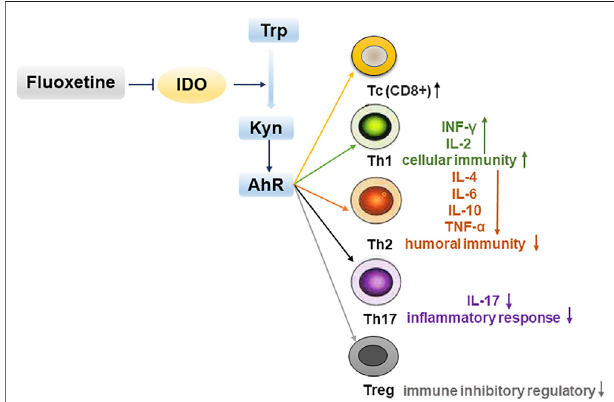
FIGURE 10 | Fluoxetine enhances cellular immunity via down-regulating kynurenine pathway-associated genes IDO1, IDO2, AhR to inhibit tumor